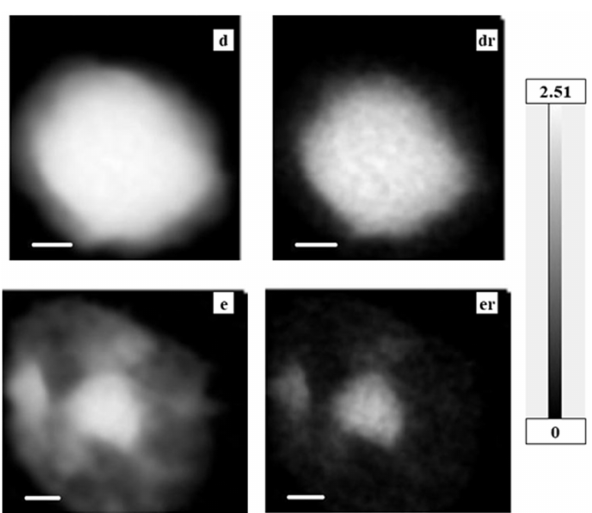
Figure 3. Absorption images on the left (spect1), with residual images after subtraction of nucleic acids and proteins (spect3) on the right. ( d , dr ) an isolated nucleus; ( e , er ) an apoptotic nucleus. All observed at 398 eV. Grayscale on the right indicates OD, which is consistent among these images to allow for comparison of observed and residual images. Scale bars represent 1 μm.